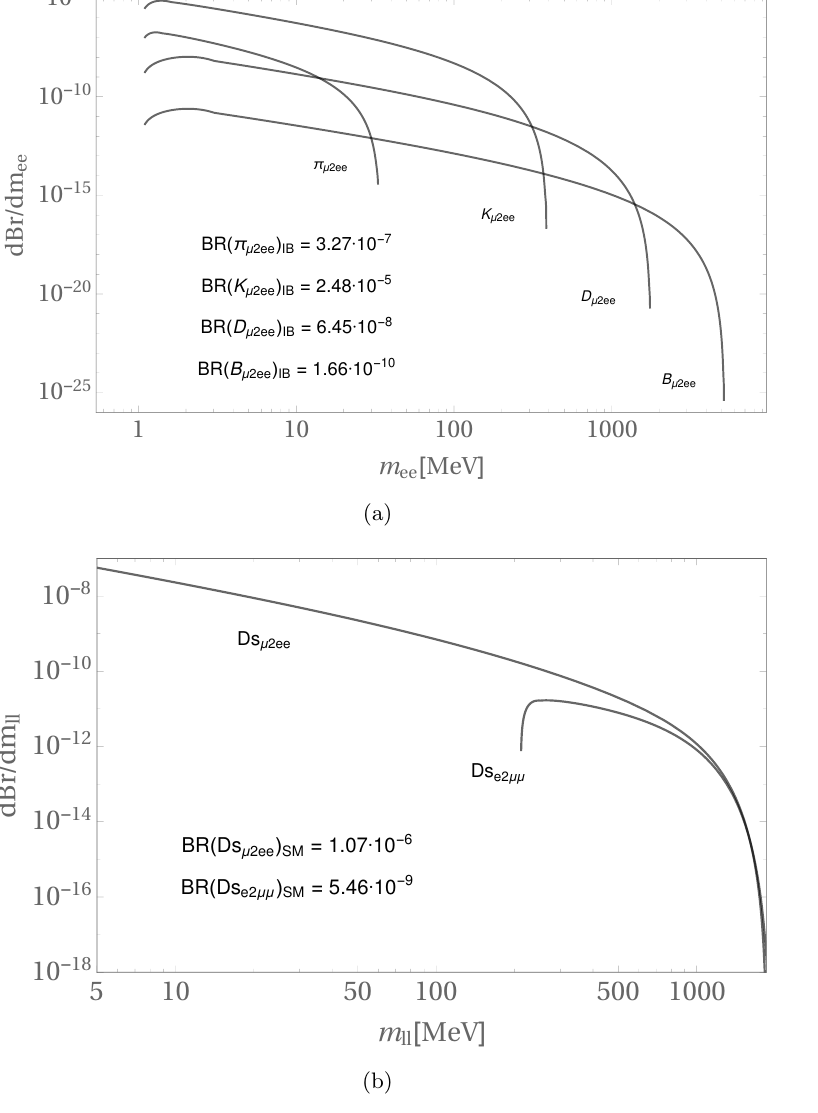
Figure 11 . Di(cid:11)erential branching ratio as a function of the di-lepton invariant mass in the SM. In the plot (a), the IB diagrams are dominant. In (b), the IB and SD contributions are presented for D s